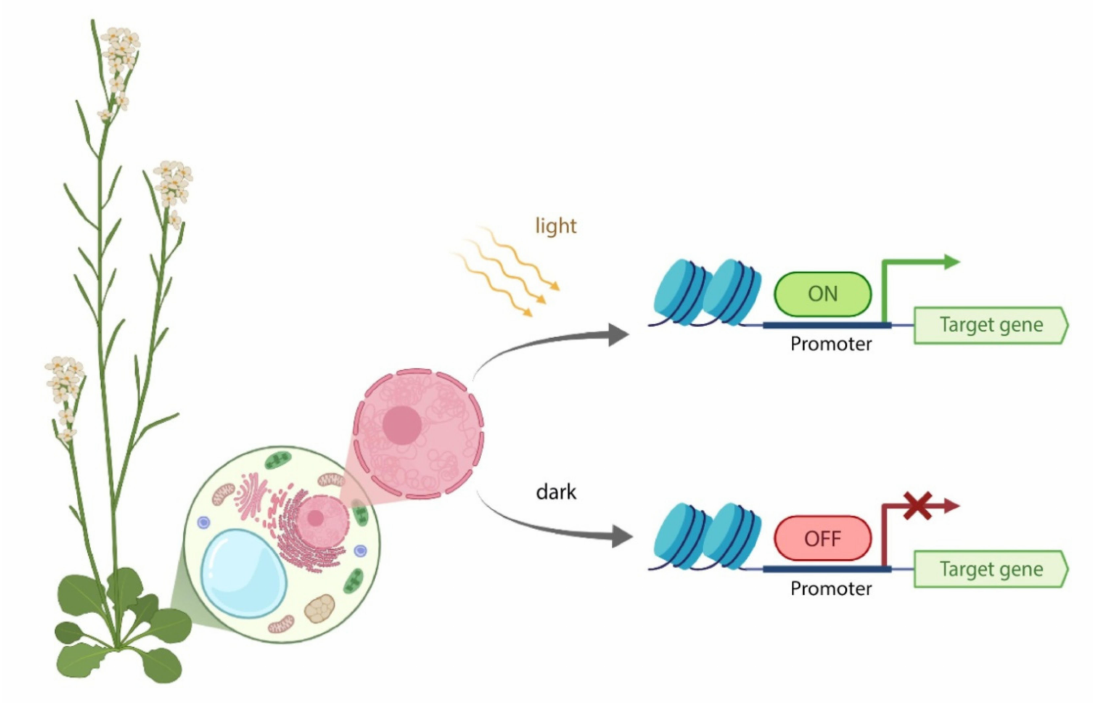
Figure 1. General strategy for optogenetic systems in plants. In dark, the system is turned off, the target gene does not express. Upon illumination with the light of a certain wavelength, the optogenetic system is activated, resulting in the transcription of the target